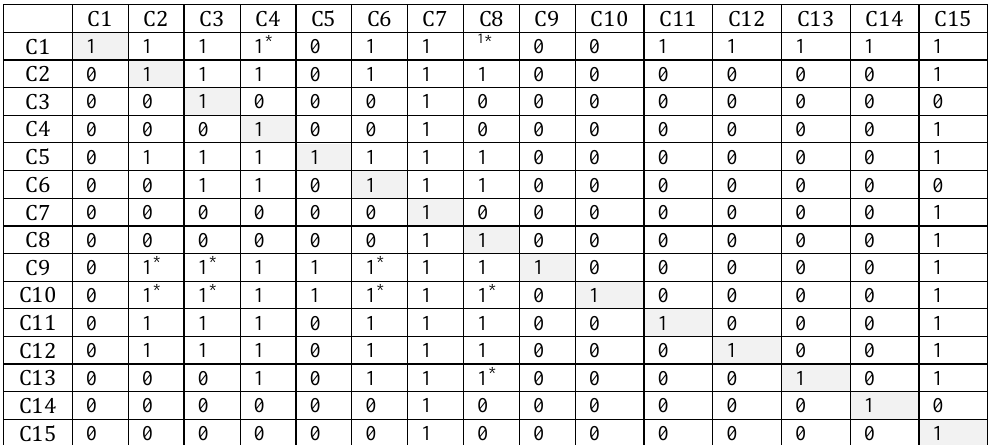
Table 11. Accessibility matrix in terms of the rate of transferability of the relationship between propositions